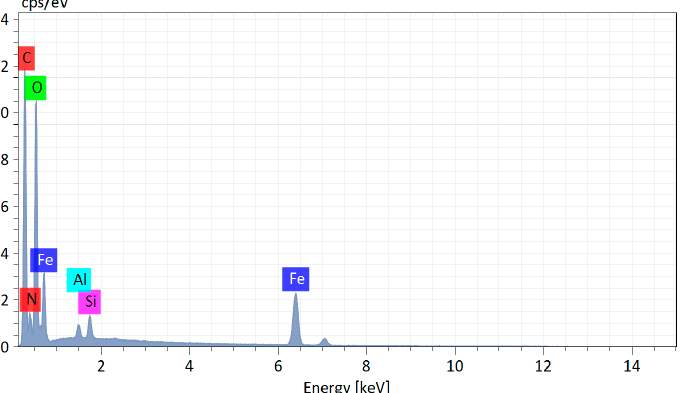
Figure 8. Energy dispersive X-ray spectrum from FeAcMTX: C—51.5 at. %; O—37.3 at. %; N—12.9 at. %; Fe—14.1 at. %. %; Fe—14.1 at.